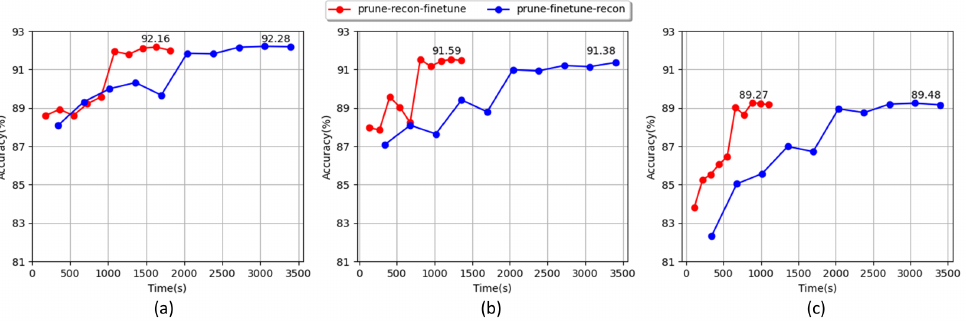
Figure 6. Comparison of training time required during the pruning–reconstruction–fine tuning process (red line) and pruning–fine tuning–reconstruction process (blue line) using pruned ResNet34 on the CIFAR-10 database; ( a – c ) refer to models with compression rates of 0.4, 0.6, and 0.8, respectively. The training time and accuracy were recorded over ten epochs. The data labels show the best accuracy of each